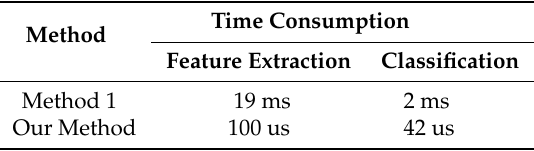
Table 1. Time performance of loop closure detection.